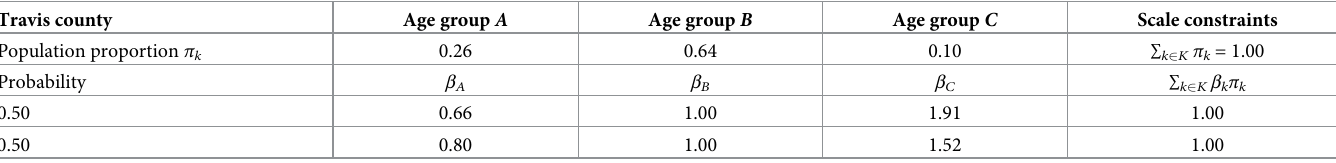
Þ used in this study for Travis county. c